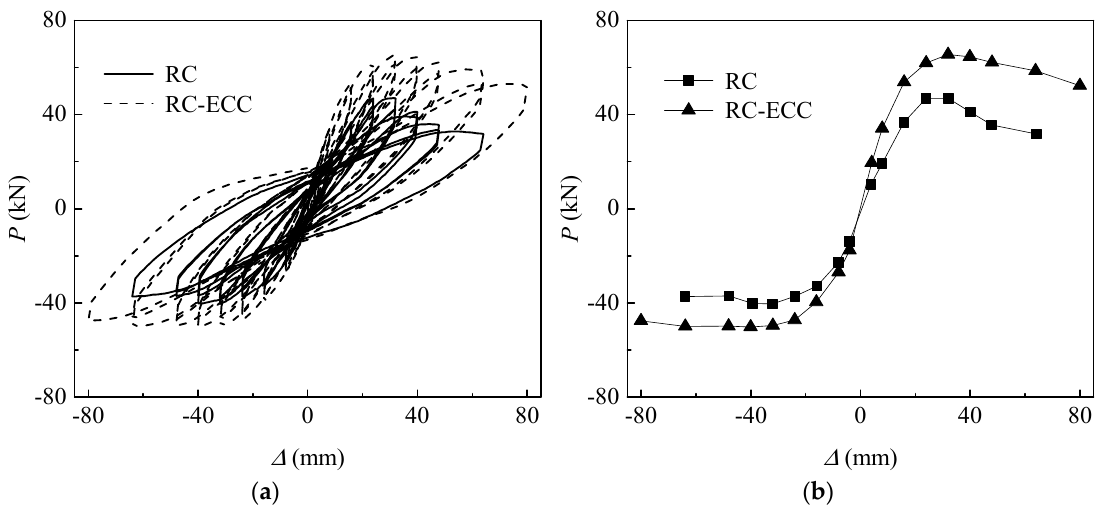
Figure 7. Comparison of cyclic load ( P ) versus lateral displacement ( Δ ) curves between RC and RC–ECC composite columns. ( a ) hysteresis curves; ( b ) envelop curves. RC–ECC composite columns. ( a ) hysteresis curves; ( b ) envelop